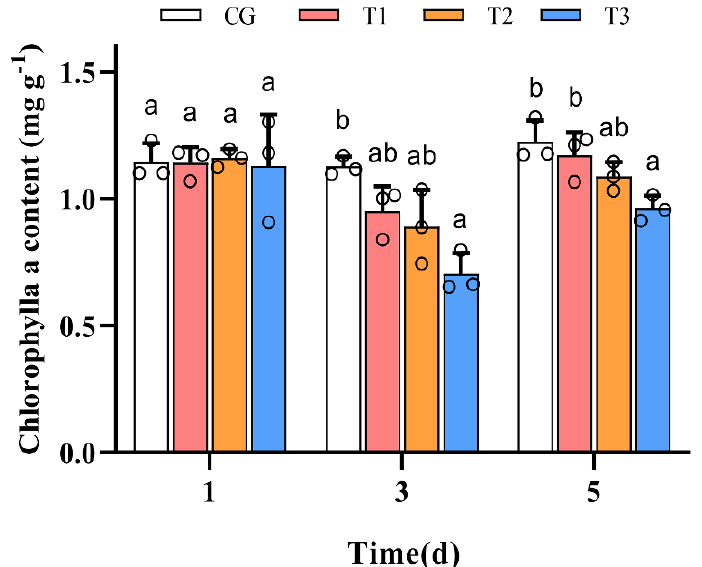
Figure 3. Chlorophyll a content for M. spicatum in each treatment on day 1, 3, and 5 (data points). CG: control group; T1: 0.1 times of original decomposing liquid; T2: 0.2 times